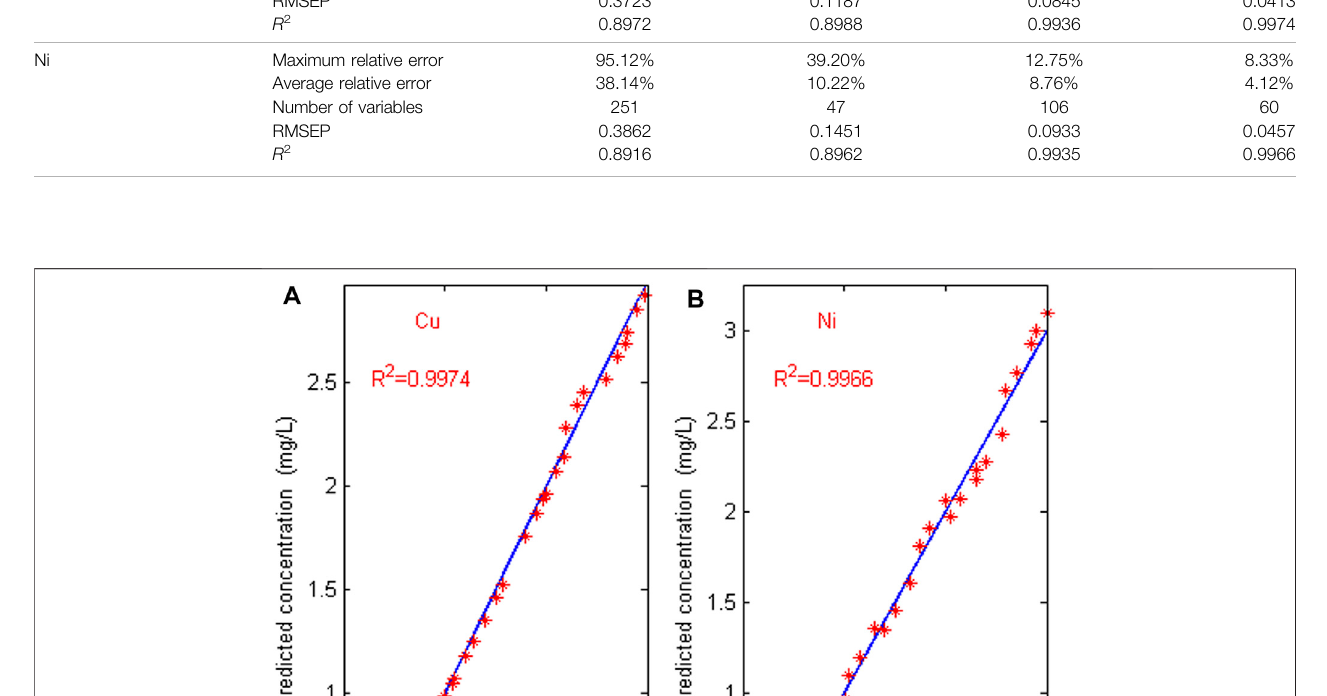
Frontiers in Chemistry |